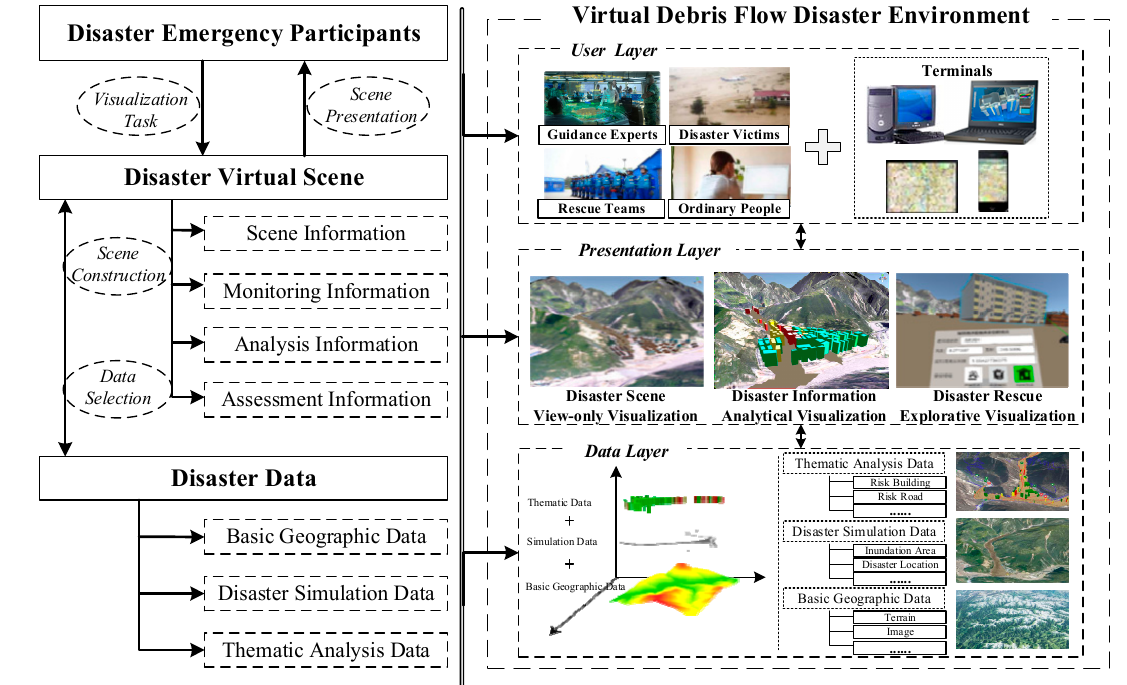
Figure 1. Framework of virtual debris flow disaster environment.